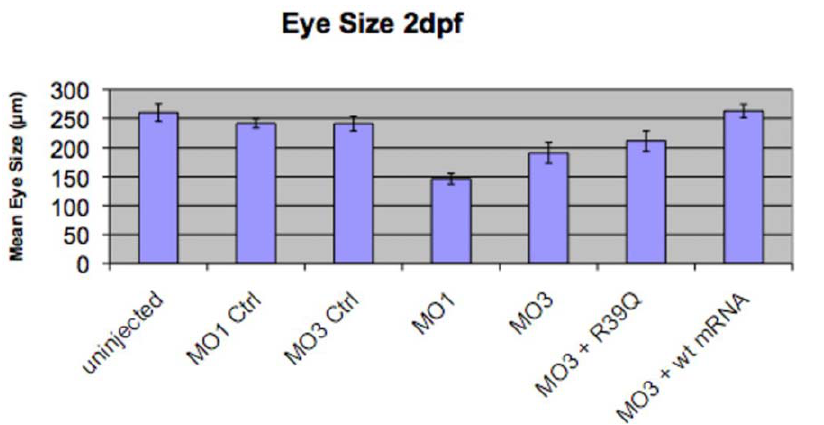
Figure 7. Co-injection of human wildtype TMX3 mRNA with a splice antisense morpholino rescues morphant eye size. Data are shown for mean eye size (measured in m m on the y-axis) at 2 dpf for uninjected, control-injected, MO1 and MO3 injected, and MO3 and human wildtype and mutant TMX3 mRNA-injected fish (categories listed on x-axis). A minimum of 10–20 fish were scored for each data point and the data is shown as mean + / 2 one standard deviation. Rescue of the small eye phenotype can be seen by the similarity in eye measurements obtained for MO3 and human wildtype TMX3 mRNA-injected larvae compared to uninjected and control-injected larvae (p . 0.05; two-sample t-test assuming equal variance).